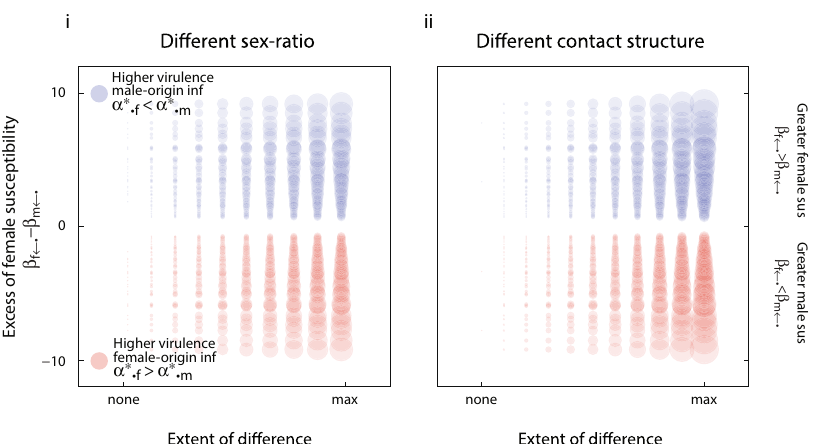
Fig. 5 Evolution of origin-speci fi c virulence with different subpopulations and different susceptibility between the sexes. On each sub-panel the difference between evolutionarily stable virulence associated with female- and male-acquired infections are plotted as circles whose area scales with the extent of the difference. Circles are centred according to the extent of the difference between subpopulations and the excess female susceptibility, de fi ned as β f ← (cid:129) − β m ← (cid:129) . There are no sex-speci fi c differences in background mortality, there was no possibility of recovery, and there was only weak mixing of populations ( σ = 0.25). In sub-panel i , the subpopulations differ only in their sex-ratio (controlled through the in fl ux of susceptible hosts), from a scenario with no difference (indicated as `none') to one in which one subpopulation is strongly female biased while the other is strongly male biased (indicated as ‘ max ’ ). In sub-panel ii , the subpopulations differ in their contract structure, from a scenario with no difference ( ‘ none ’ ) to one in which in subpopulation A , contacts are exclusively same-sex ( c A i $ j ¼ c A j $ j ), while in subpopulation B , contacts are exclusively cross-sex ( c B i $ j ¼ c B : j $ j